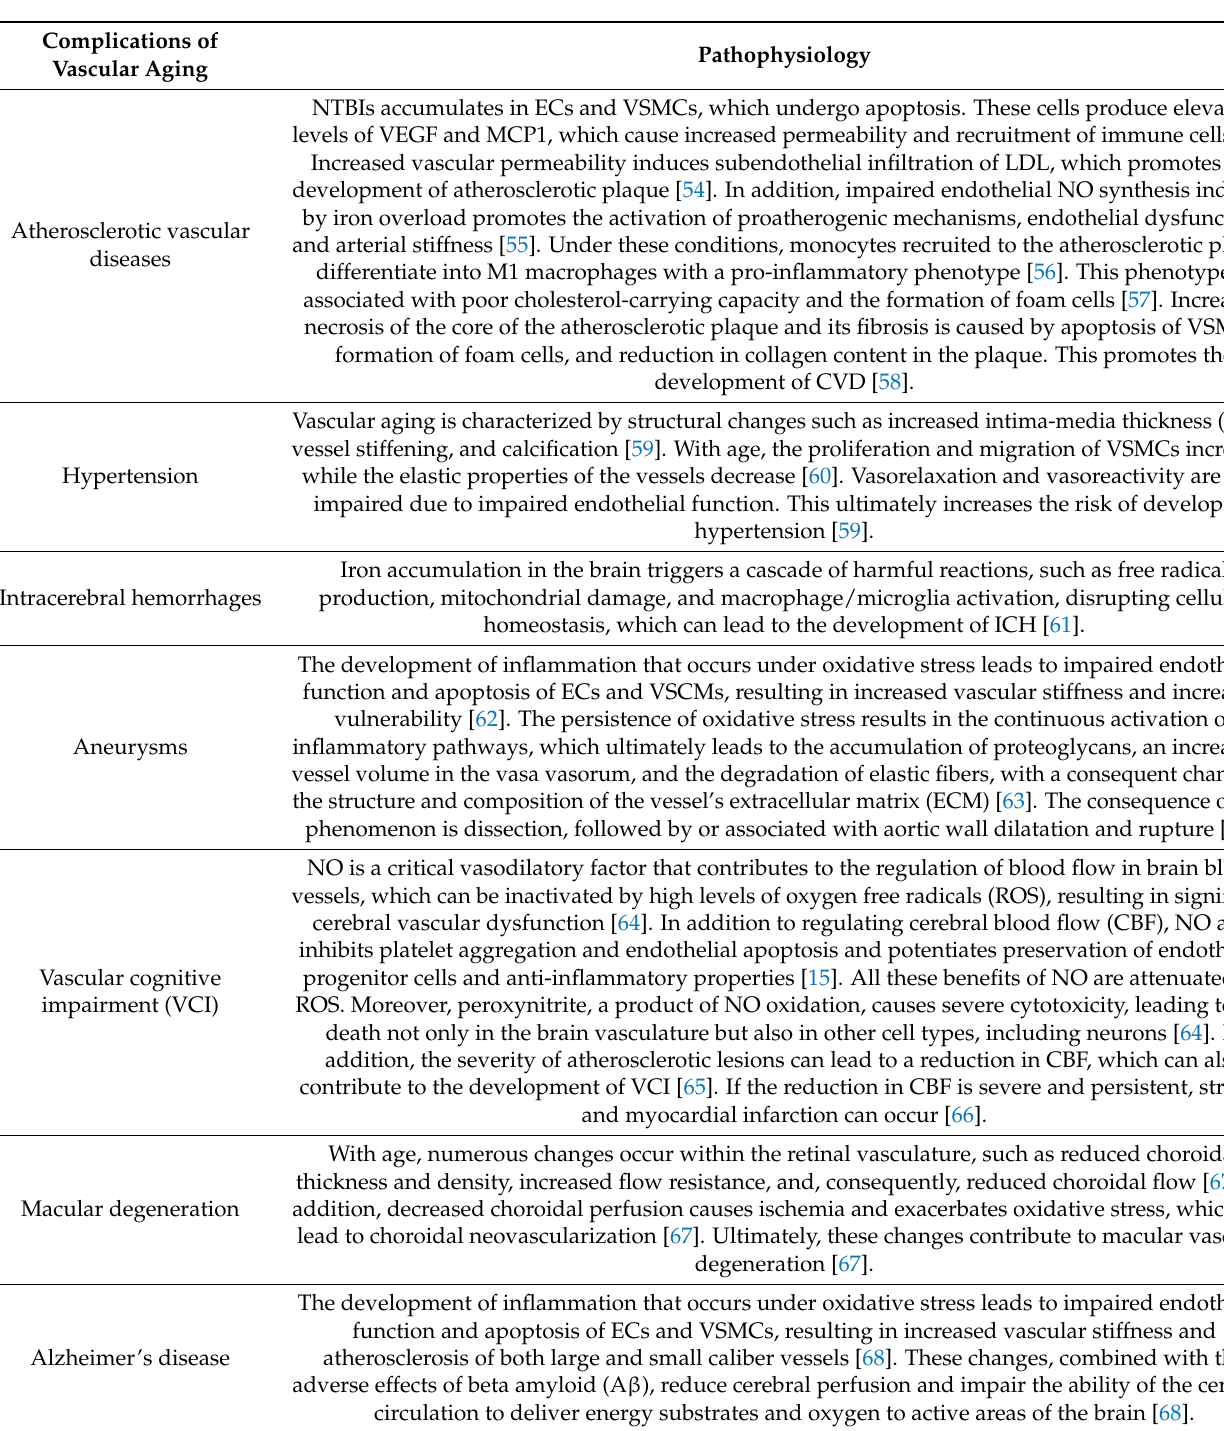
Table 2. Pathophysiology of clinical complications associated with vascular